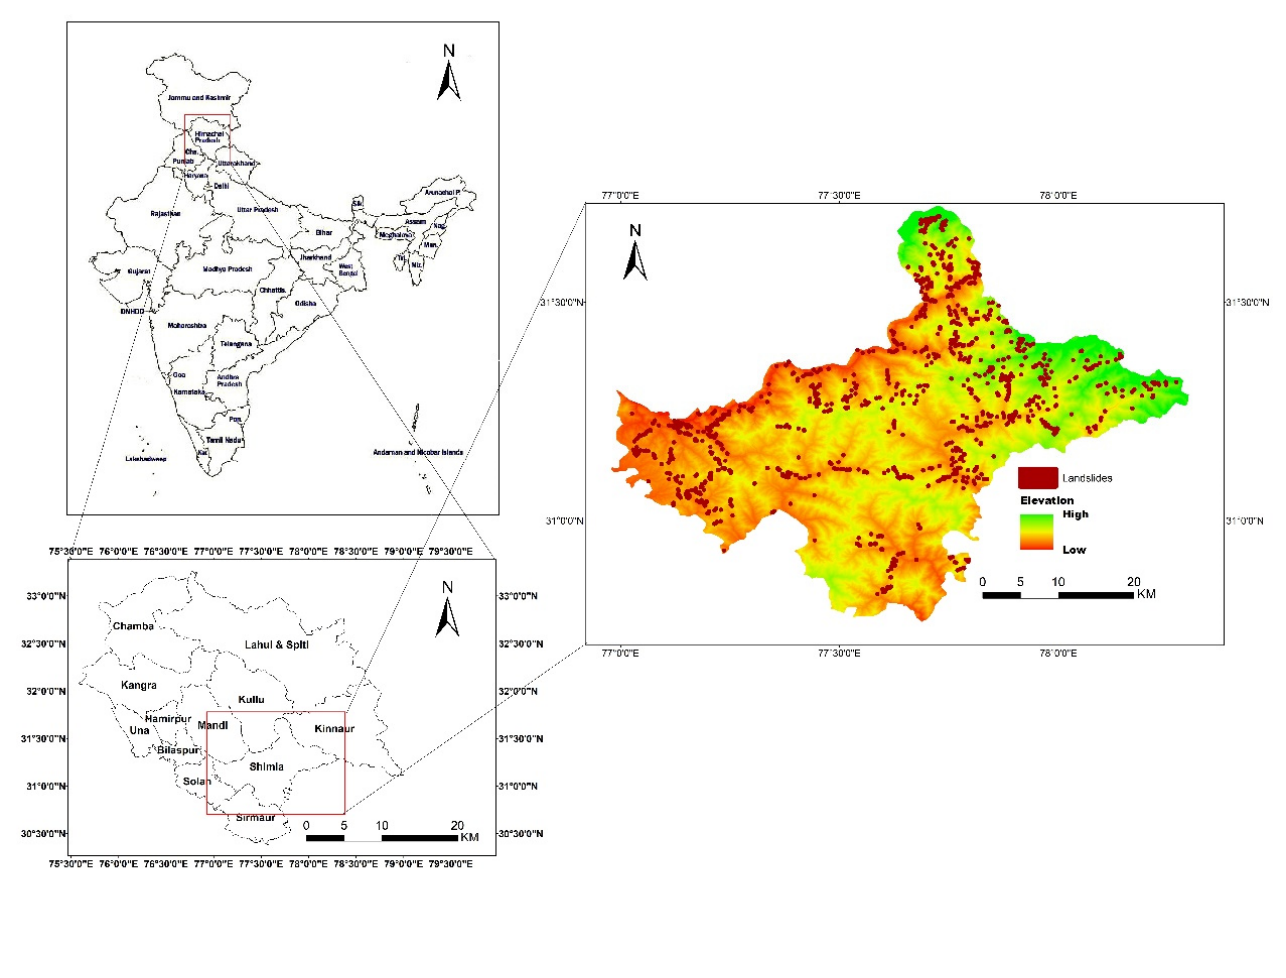
Figure 1. ( a ) Flow chart of methodology, ( b ) Study area and landslide inventory.